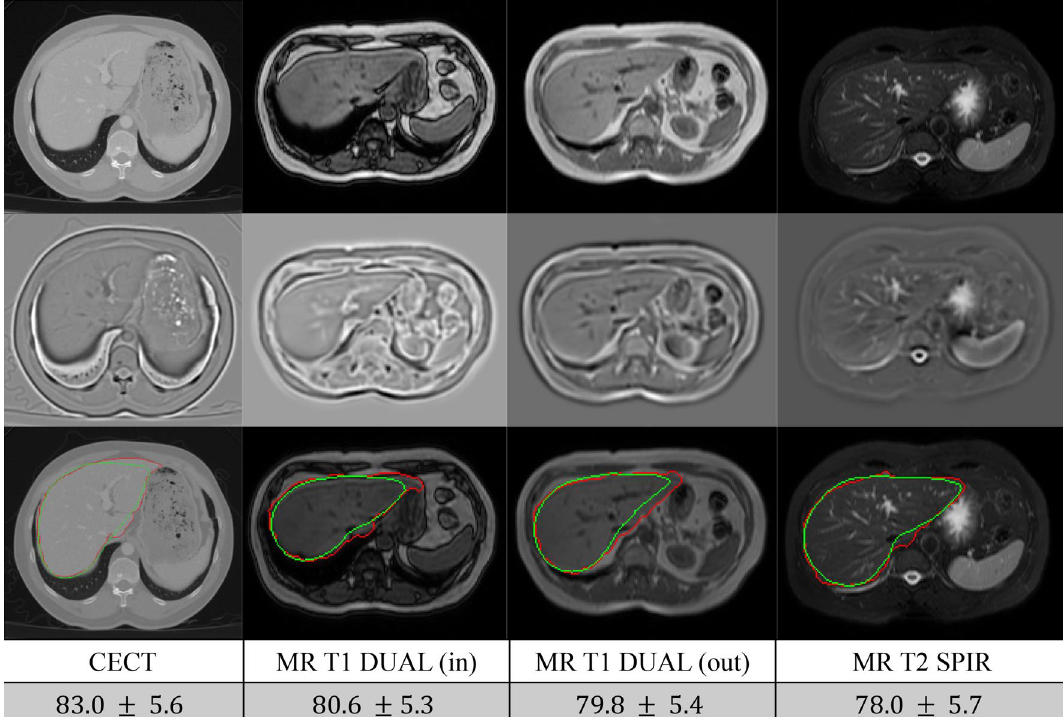
Figure 3. An example of the CHAOS multi-modal segmentation dataset. The top row shows the original images (CECT, MRI T1 in-phase, MRI T1 out-phase, MRI T2-SPIR). The middle row shows associated pre-processed images using the LoG filter. The bottom row displays the original images together with the segmentation estimates (green) and ground truth